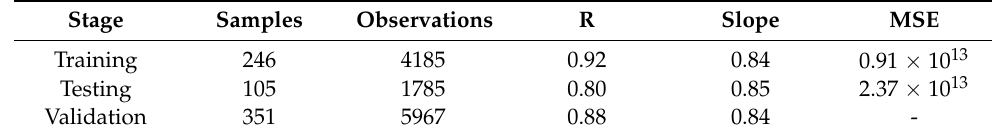
Table 6. Regression machine learning model results in predicting 17 volatile aromatic compounds using NIR absorbance values as input. Abbreviations: R—correlation coefficient; MSE—means squared error.